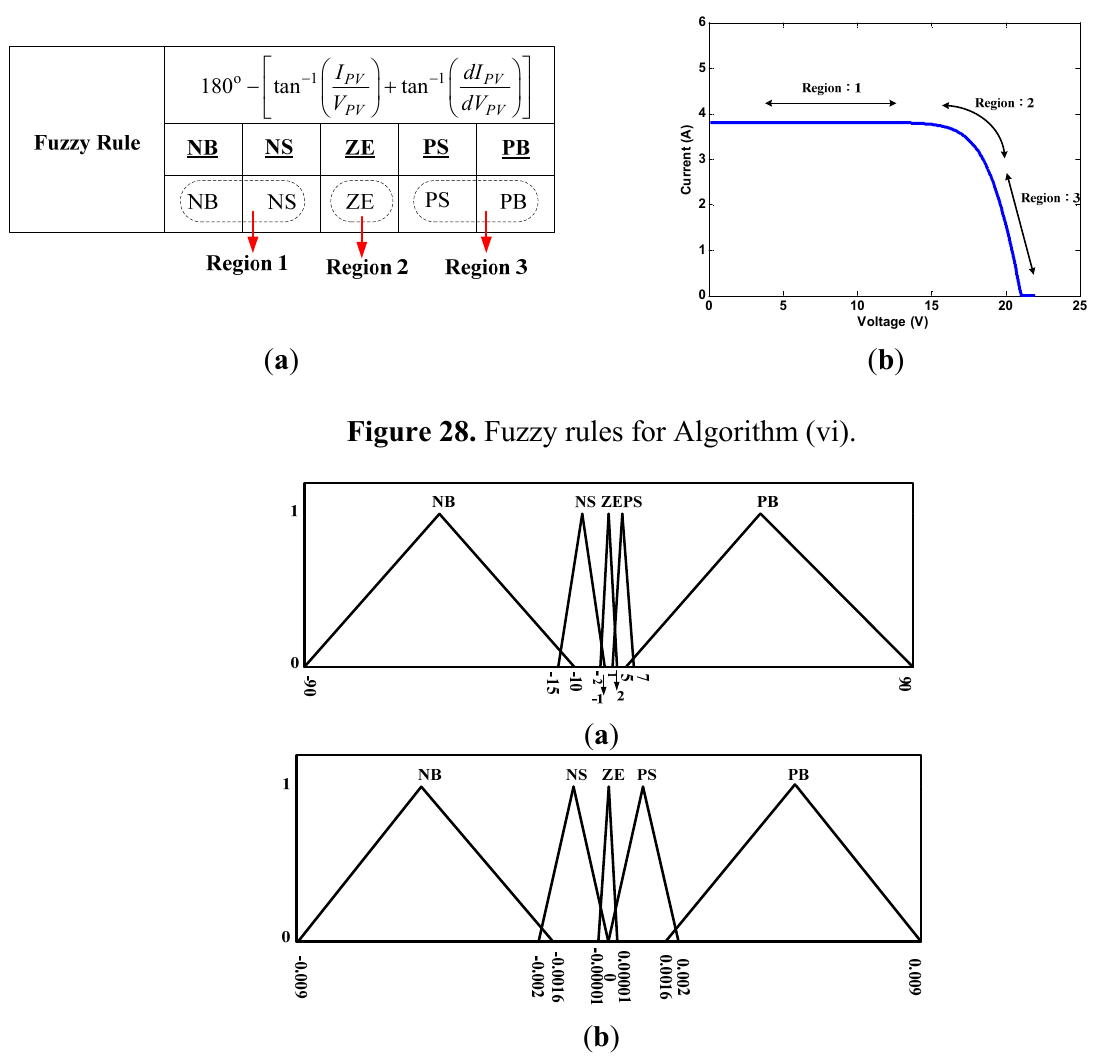
Figure 29. Membership functions for Algorithm (vi): ( a ) Membership function for θ  ( b ) Membership function for increment of duty ratio